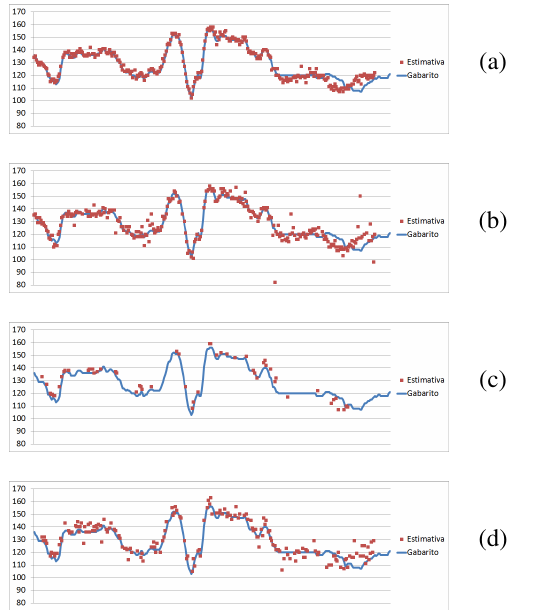
Fig. 5. Left superior point estimated path on video MGL.5 y coordinate (a)Pure red channel, (b) Pure green channel, (c) Luminance, (d)